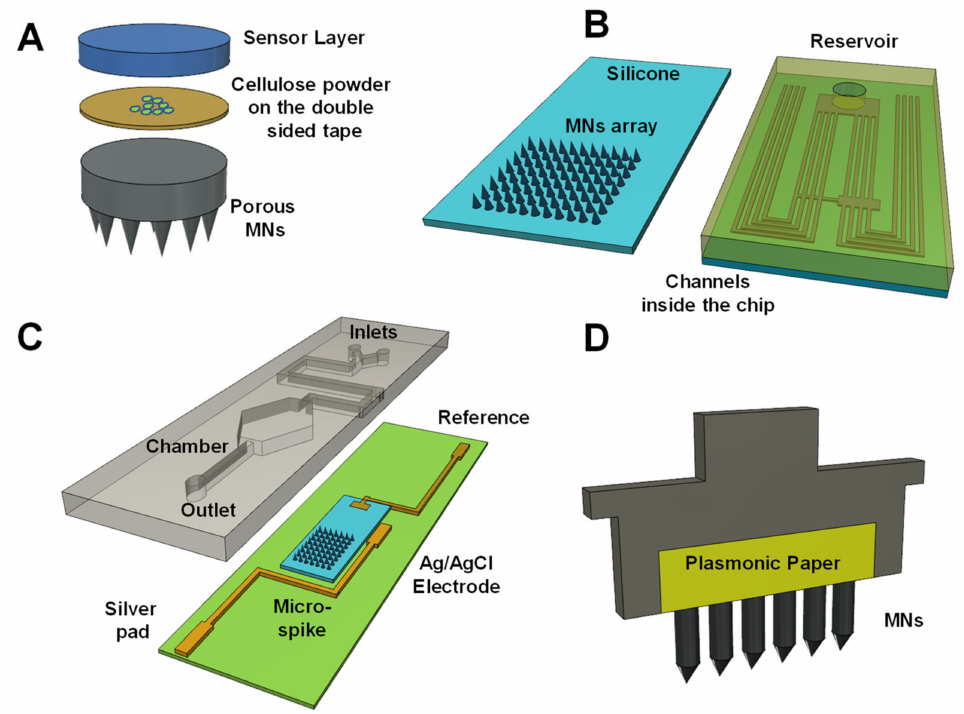
Figure 9. Integrated MN arrays with the microfluidic system: ( A ) A porous MN array made of PDMS. The array is connected to paper-based colourimetric glucose sensors [140]. ( B ) A hollow MN array connected to a set of microchannels, and a common reservoir [66]. ( C ) A solid MN array (microspike) coated with an enzyme layer [177]. The MN array was connected to a microfluid system for further investigations. ( D ) A MN array attached to a plasmonic paper [177]. The absorbed ISF in the paper was investigated by surface-enhanced Raman spectrometry (SERS). Figures were redrawn from References [66,140,176,177], respectively. Figures are not drawn to